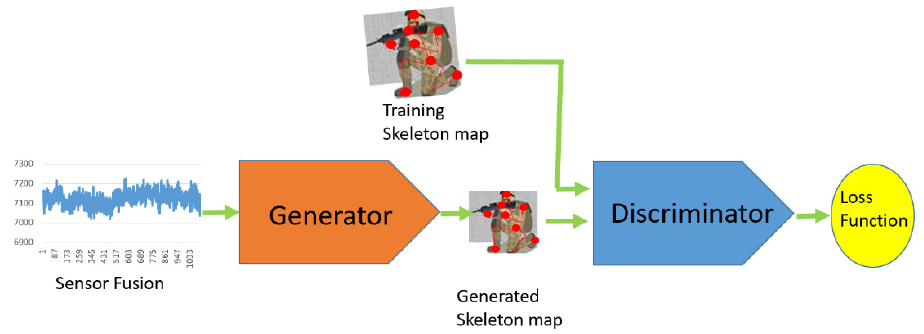
Figure 5. The proposed generative adversarial network.